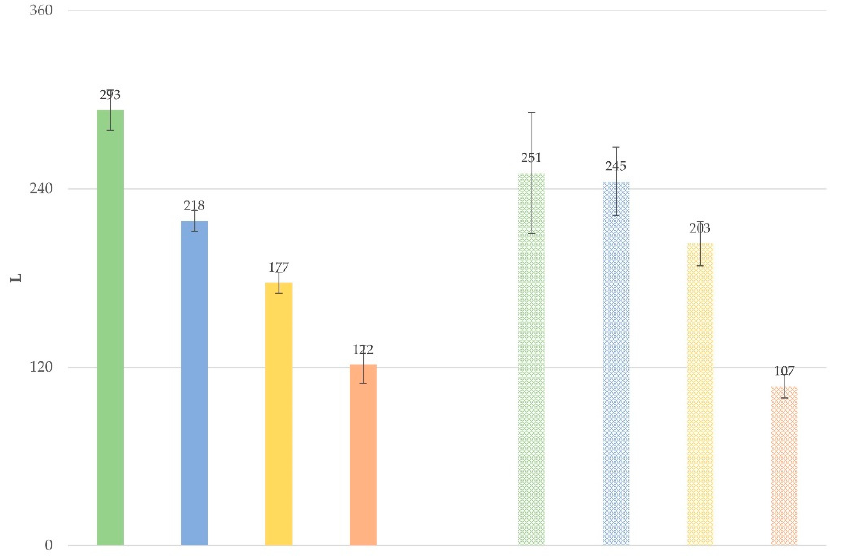
Figure 2. Average yearly milk production per animal in sheep (solid pattern) or goat (motif pattern) farms in Greece, applying the intensive (green), semi-intensive (blue), semi-extensive (yellow) or extensive (red) management system.